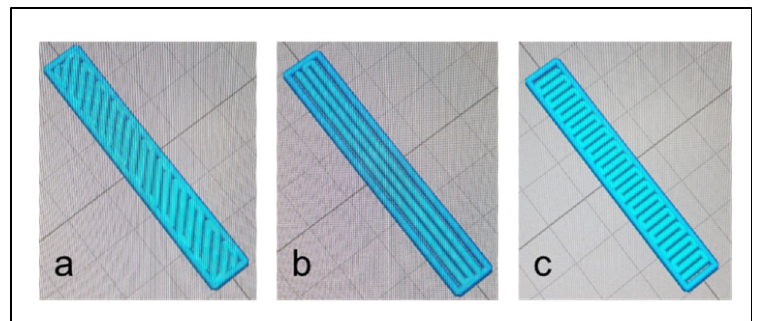
Figure 1. The different 3D printing patterns according to the three different raster angles: ( a ) +45°/ − 45°, ( b ) 0°, and ( c ) 90°. − 45 ◦ , ( b ) 0 ◦ , and ( c ) 90 ◦